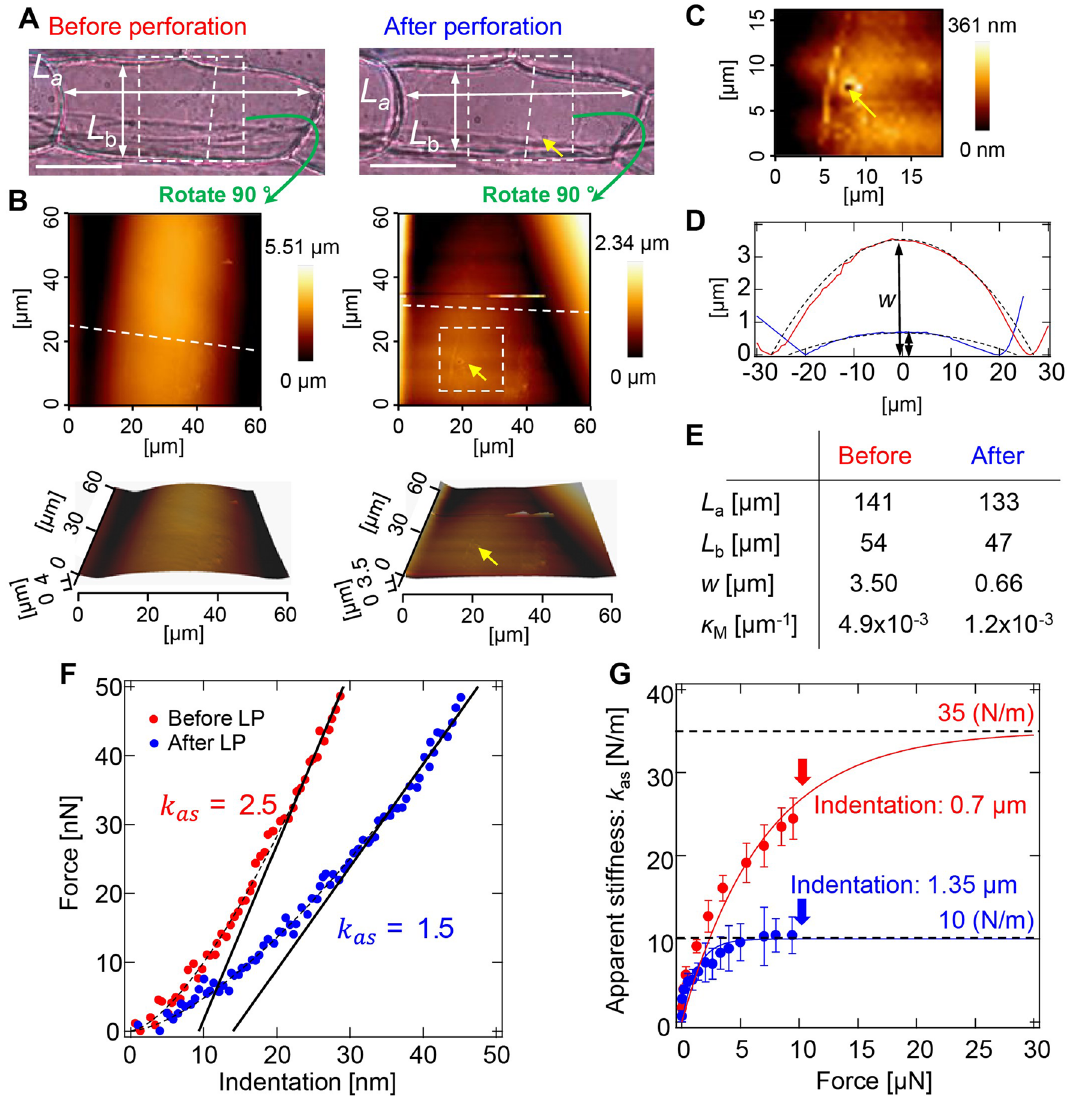
Figure 3. AFM measurement of an onion epidermal cell with laser perforation. ( A ) Photographs of the cell measured before (left) and after (right) perforation. Yellow arrow indicates the perforation point. Cell lengths along long- and short- axes are denoted by L a and L b , respectively. Bars, 50 µm. ( B ) Topographic images before (left) and after (right) perforation. Measurement area corresponds to the dashed box area in ( A ). Lower images are three-dimensional images of upper images. ( C ) Enlarged image of the perforation point. ( D ) Cross-sectional graph of the cell wall surface before (red line) and after (blue line) perforation, corresponding to the height of dashed lines in upper-left and -right images in ( B ), respectively. Bulge height of the cell surface is denoted by w . Dashed lines are curves for curvature calculated from L b and w . ( E ) Quantities determined from AFM measurement. Mean curvature of the cell wall surface κ M is calculated from L a , L b , and w . ( F ) Force–indentation curves of the cell wall before (red dots) and after (blue dots) perforation. Dashed lines are fitting curves by the Hertz model and solid lines are fitting lines by the shell model. ( G ) Apparent stiffness k as as a function of force F applied to the cell wall before (red dots) and after (blue dots) perforation. k as is estimated by linear least squares fitting of the force-indentation curve in the vicinity of the F , as shown in (F). Bars on dots represent root mean squared error. Solid lines are exponential plateau curves: k as = 35 × {1 − exp(− F /7)} (red line); k as = 10 × {1 − exp(− F /1.28)} (blue